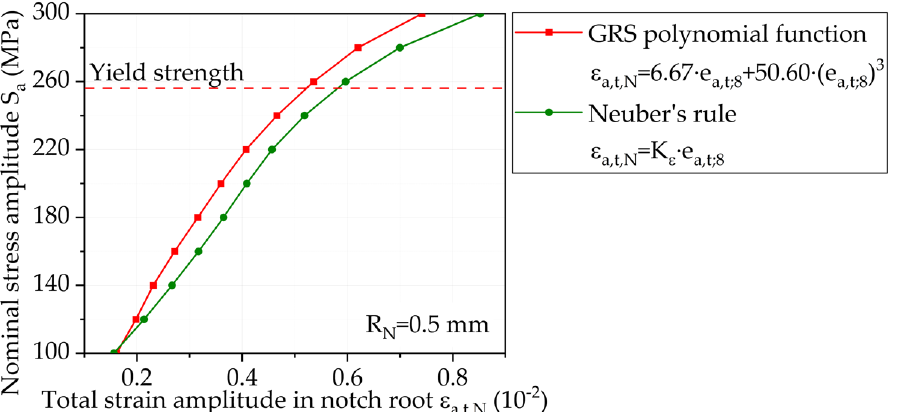
Figure 15. Comparison of calculated values using polynomial function derived from FEM simulation and analytical approaches for specimens with R N = 0.50 mm.